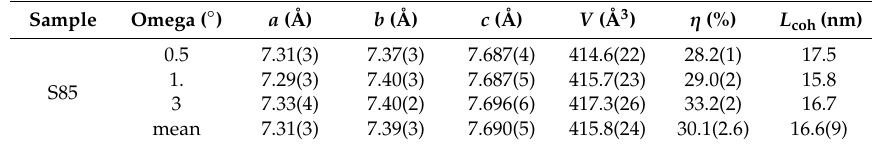
Table A1. The GIXRD results for all measured samples and di ff erent omega angles, i.e., 0.5 ◦ , 1 ◦ , and 3 ◦ . a , b , and c parameters are the cell constants. V is a cell volume, η is a degree of preferred grain orientation along (002) direction and L coh is a coherence